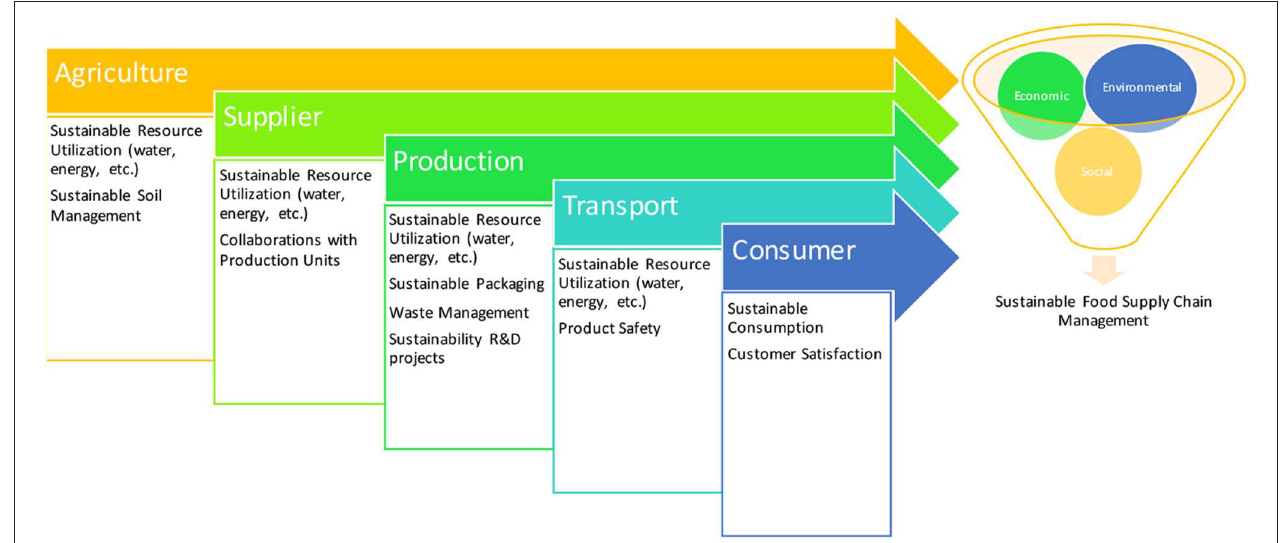
FIGURE 1 | Schematic representation of the criteria in